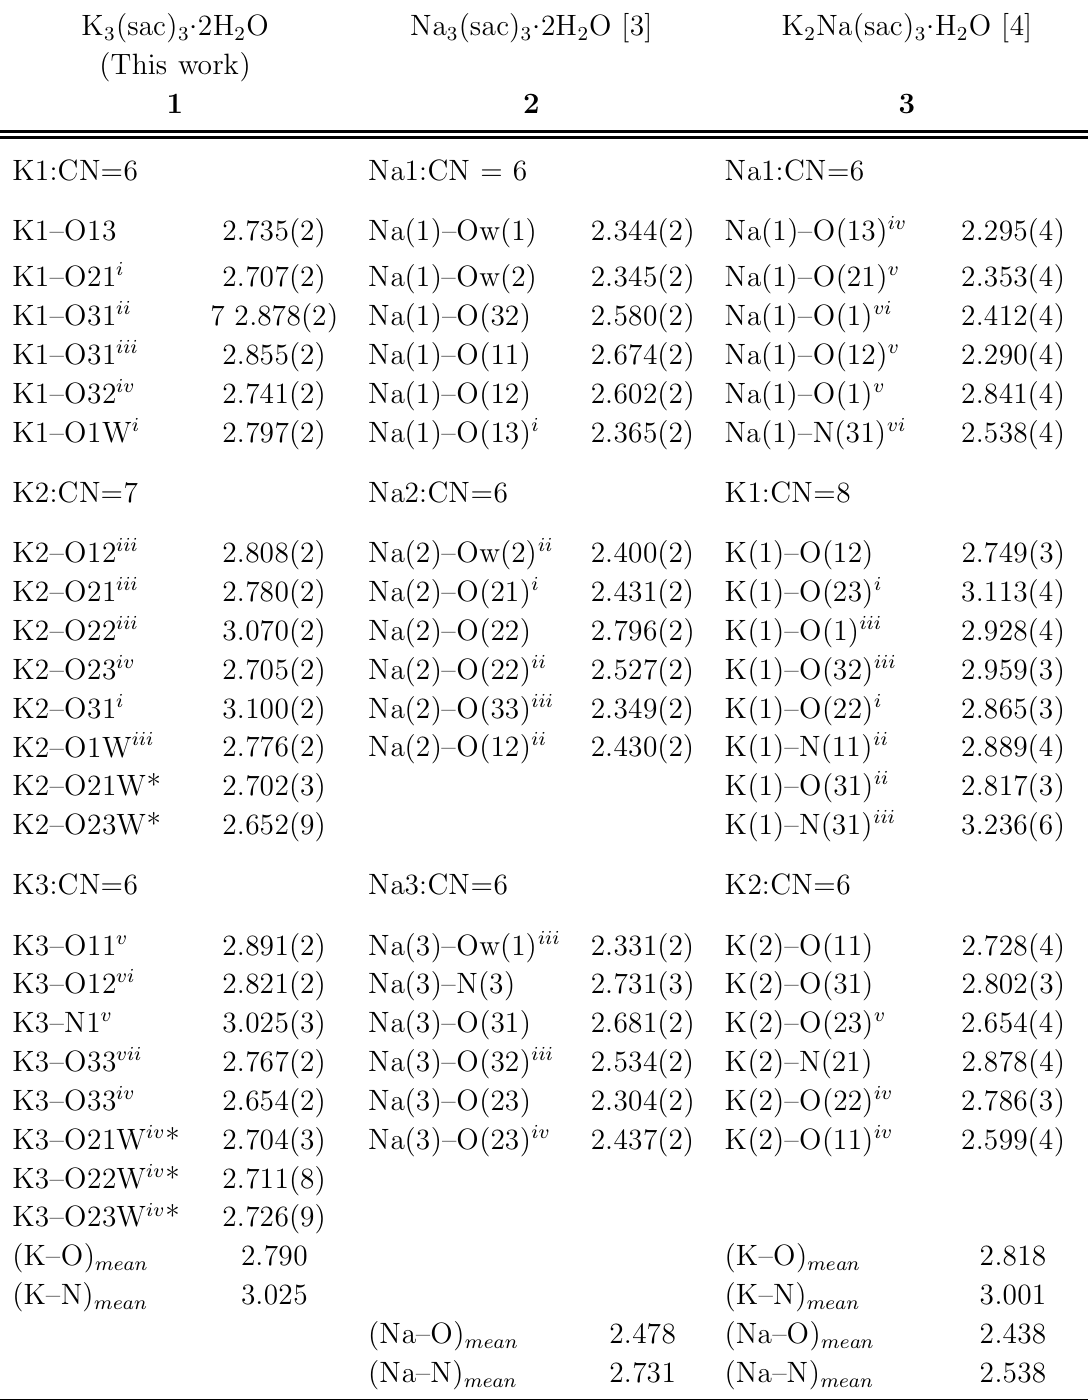
Table 2 Interatomic distances (¸A) involving the K + and Na + ions in the structures